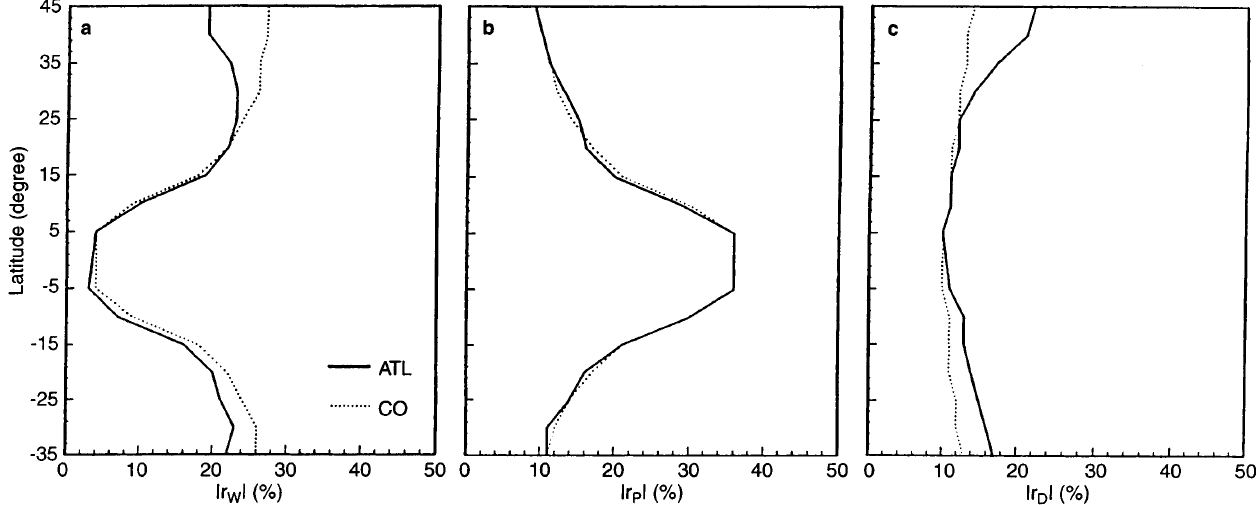
Fig. 7a–c. Linear energy flux coe(cid:129)cient (%) at di(cid:128)erent latitudes (degree). a r meridional boundary ( C0 ). Wave period: 180